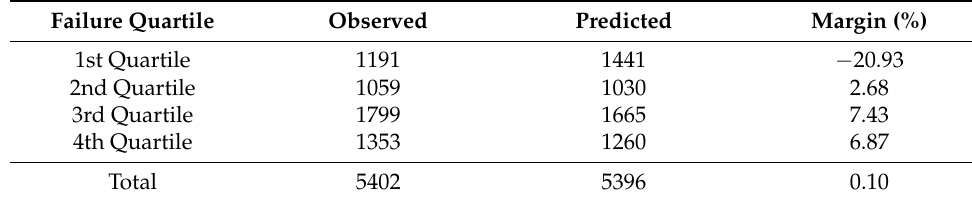
Table 6. Quartile of the pipe failures with MCMC estimation.